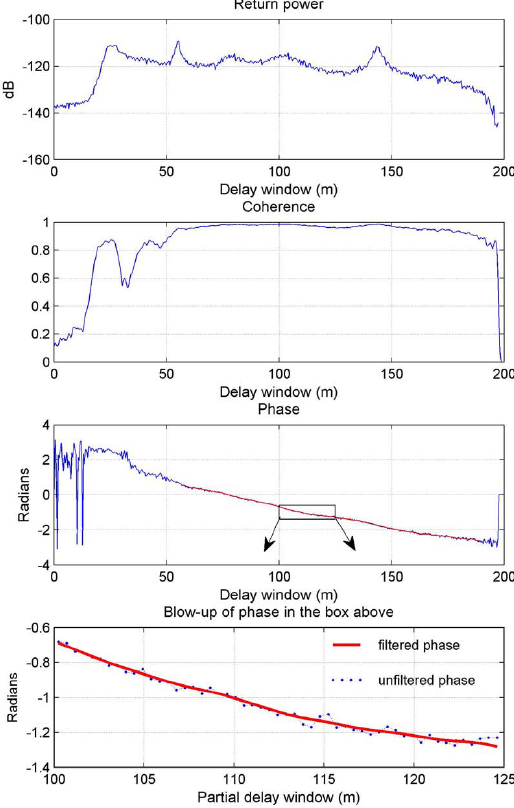
Fig. 6. Top: profile of the return power for the scan line at the po- sition of the white arrow in the illustration of return power in the upper part of Fig. 5. Note the leading edge is relatively weak, in- dicative of the low two-way antenna gain at the POCA cross-track angle. The strong delayed returns reflect the fact that the delayed main-beam returns have a much stronger two-way antenna gain. Second from top: profile of the smoothed coherence for the same scan line. Note that the dip in the coherence at ∼ 30m in the delay window corresponds to the situation when the baseline decorrela- tion affects the “cross terms” discussed in the text. The high coher- ence for the range window between ∼ 60 and 180m implies that the interferogram can be represented by Eq. (5) and that the returns are dominated by those from the main footprints. Third from top: the original phase from the L1b file is shown for the scan line in blue. The region of the scan line for which processing was done is shown in red. Note that the phase has been low pass filtered, the boxed region in this figure has been blown up in the bottom figure and illustrates the degree of smoothing; the red line is the unwrapped smoothed phase and the blue dots are the original values. Although it is slope dependent the sampling and resolution in the across-track direction is normally better than in the along-track direction, even with this smoothing.